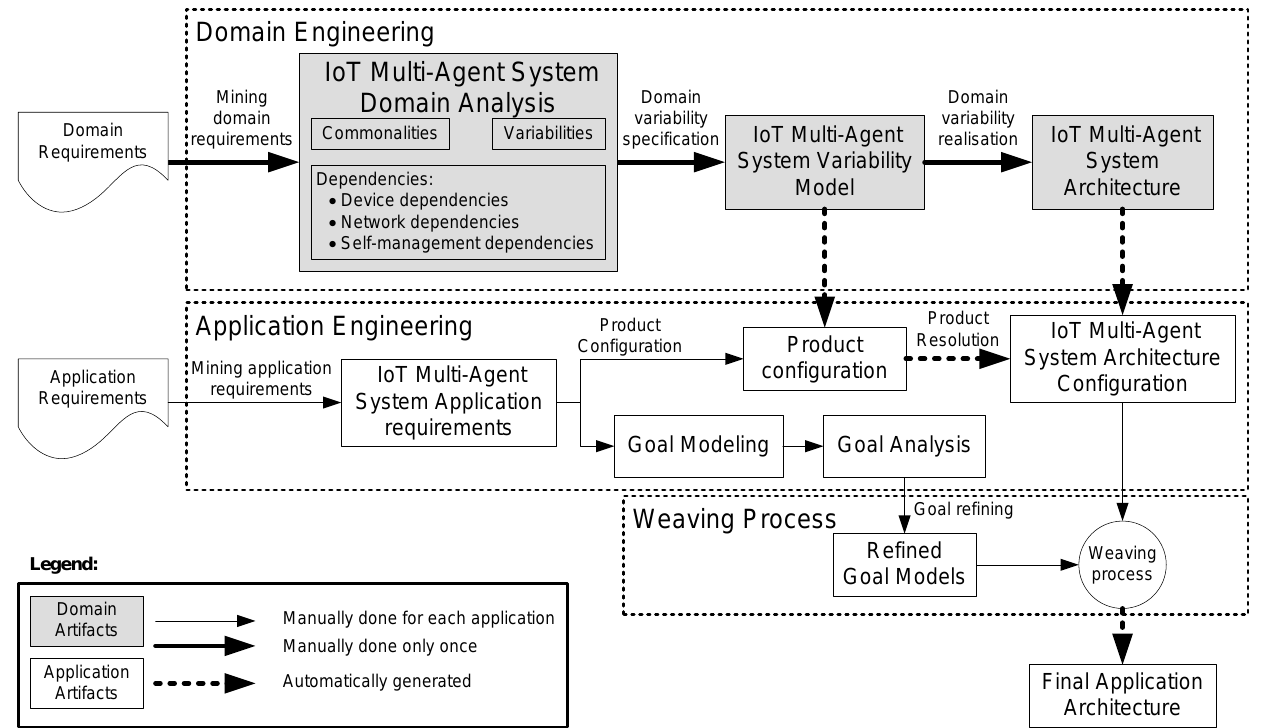
Figure 2. SPL process for Self-StarMAS agents. MAS, multi-agent